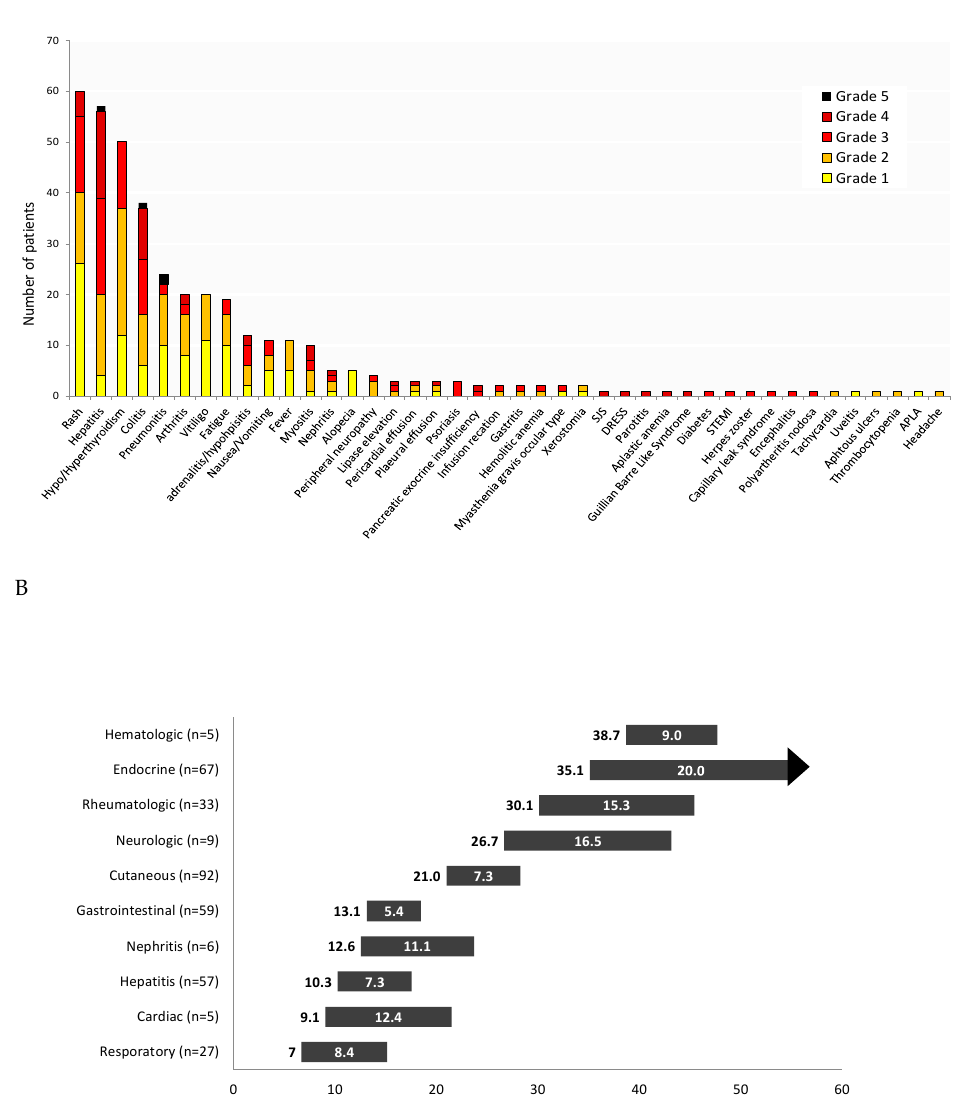
Figure 2. ( A ). Treatment-related adverse events in patients treated with ipilimumab and nivolumab. ( B ). Median onset and median duration of immune related adverse events (weeks).